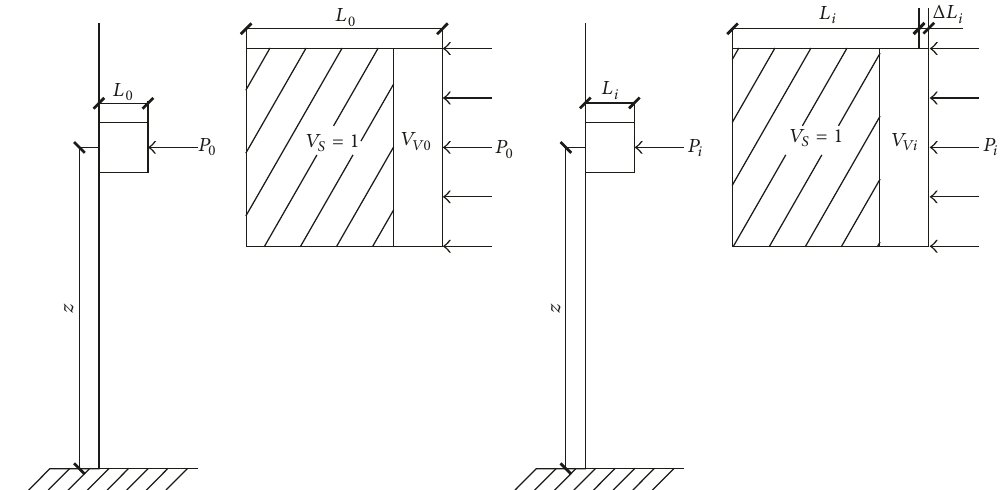
Figure 4: Earth pressure on the retaining wall.